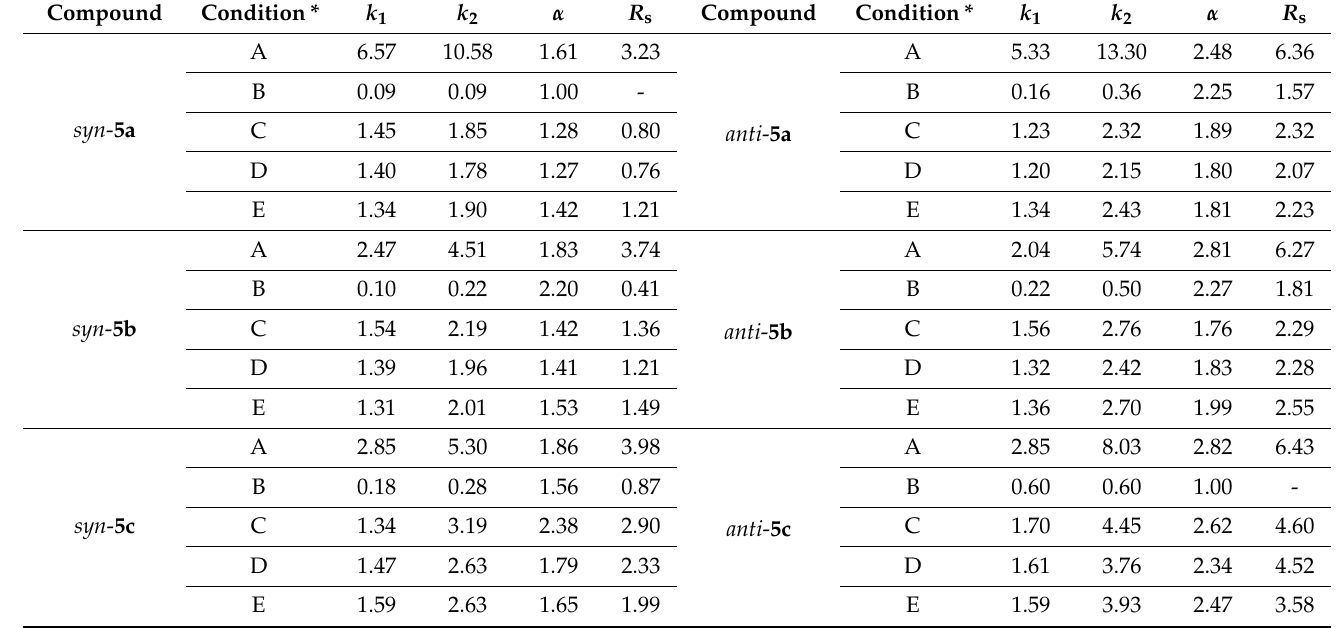
Table 1. Chromatographic parameters for the enantioselective separations of racemic syn -and anti - 3,5-disubstituted hydantoins on